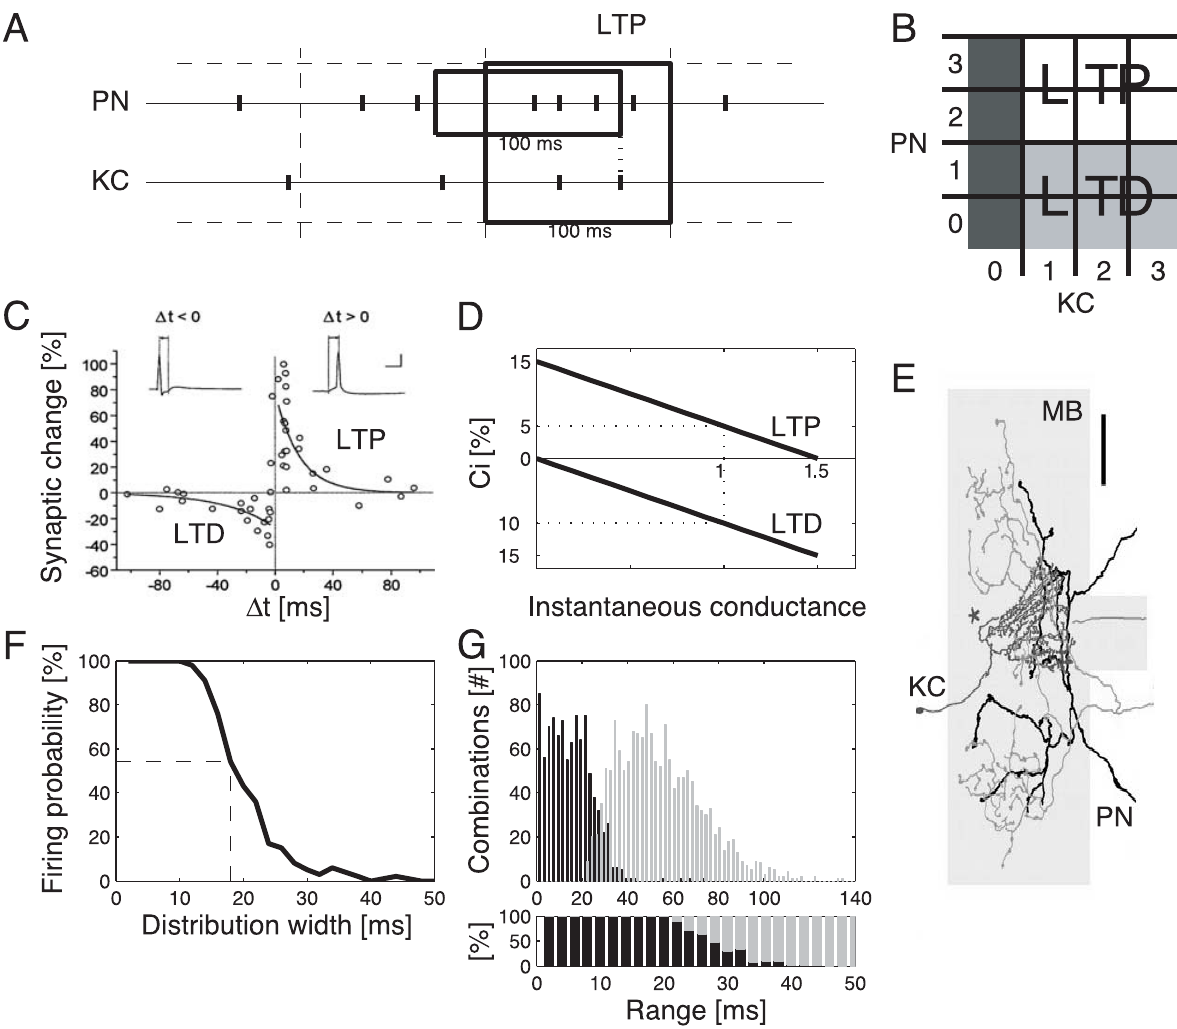
Figure 1. Synaptic plasticity and coincidence detection in the model Kenyon cell. (A) The SRDP rule was applied every 100 ms (large box over dashed time grid, see Materials and Methods). For each KC spike within that window, the instantaneous PN firing rate was estimated in the preceding 100 ms (small box; for this potentiation example: 3 spikes, or 30 Hz). (B) SRDP learning rule look-up table for potentiation (white), depression (light gray), and no change (dark grey), embodying the interaction of a PN discrete covariance term and a KC binary term. Axes indicate spike counts in 100 ms windows, as exemplified in A. (C) The pairing time window for STDP was determined by two exponentially decaying functions critically depending on the timing difference between the onset of the excitatory postsynaptic potential (EPSP) and the peak of the postsynaptic action potential. (See Materials and Methods; from [57]. Copyright 1998 by the Society for Neuroscience. Reprinted with permission.) (D) Linear dependence of synaptic change on instantaneous synaptic strength (factor Ci, Equation 1). Values normalized by the initial conductance g* . (E) Representative connection between a PN axon (black) and a KC dendritic tree (gray) in the MB calyx (light gray). (From [7]. Reprinted with permission from AAAS.) (F) Gaussian distributions of increasing width (=2 6 STD, abscissa) generated input trains of 10 spikes with decreasing probability of triggering a KC spike (see also [G]). Probability was higher than 50% for widths of 18 ms or less (dashed line). (G) Input combinations generated in (F) resorted according to the actual interval between first and last spike (range). Coincidence detection events (KC spike; black bars, 2-ms steps) predominated against non-firing combinations (gray bars) for ranges up to 26 ms (upper panel: total count; lower panel: relative count). Coincident spikes within a 20 ms range were always